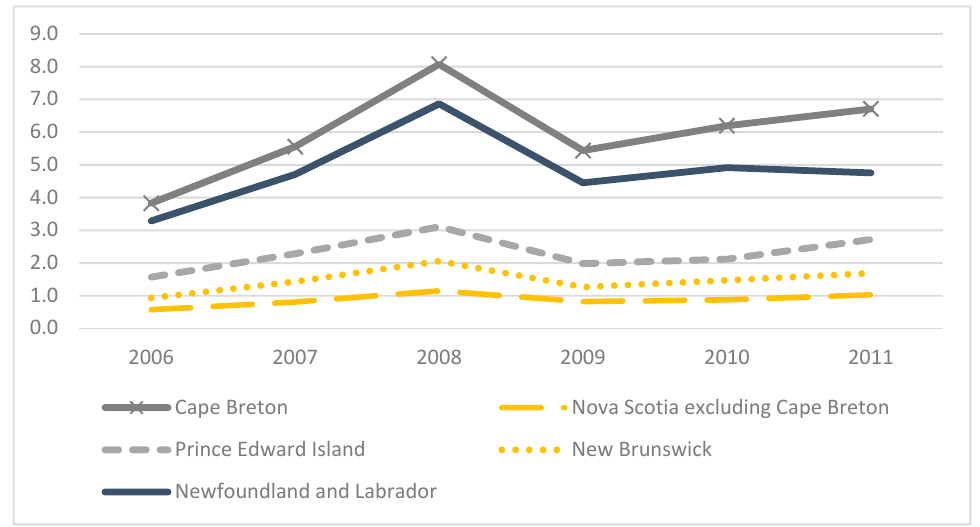
Figure 7. Percentage of aggregate wages and salaries (earned by residents of a given region) coming from interprovincial employment in Alberta.